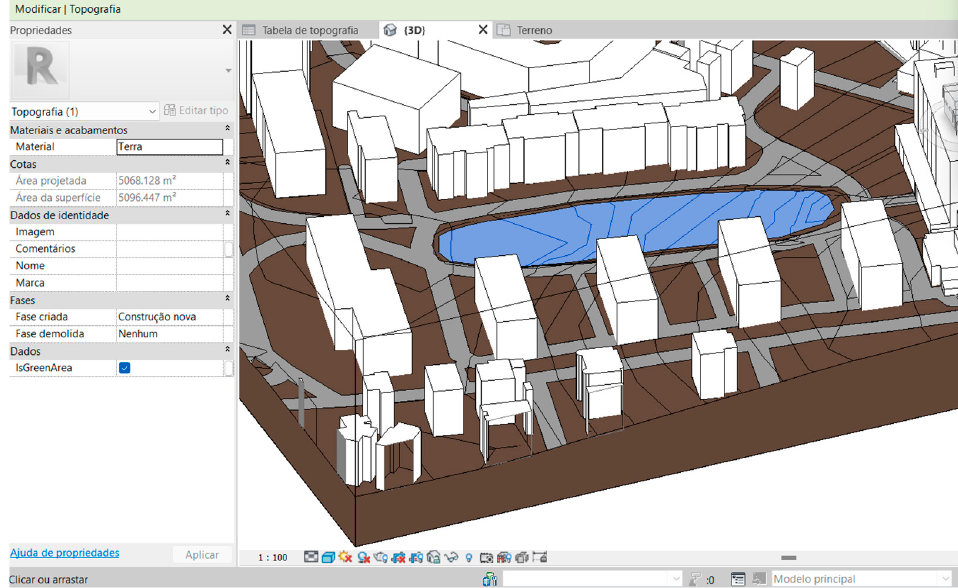
Figure 4. Selected areas in Revit and characterized according to the parameter “ IsGreenArea ”.